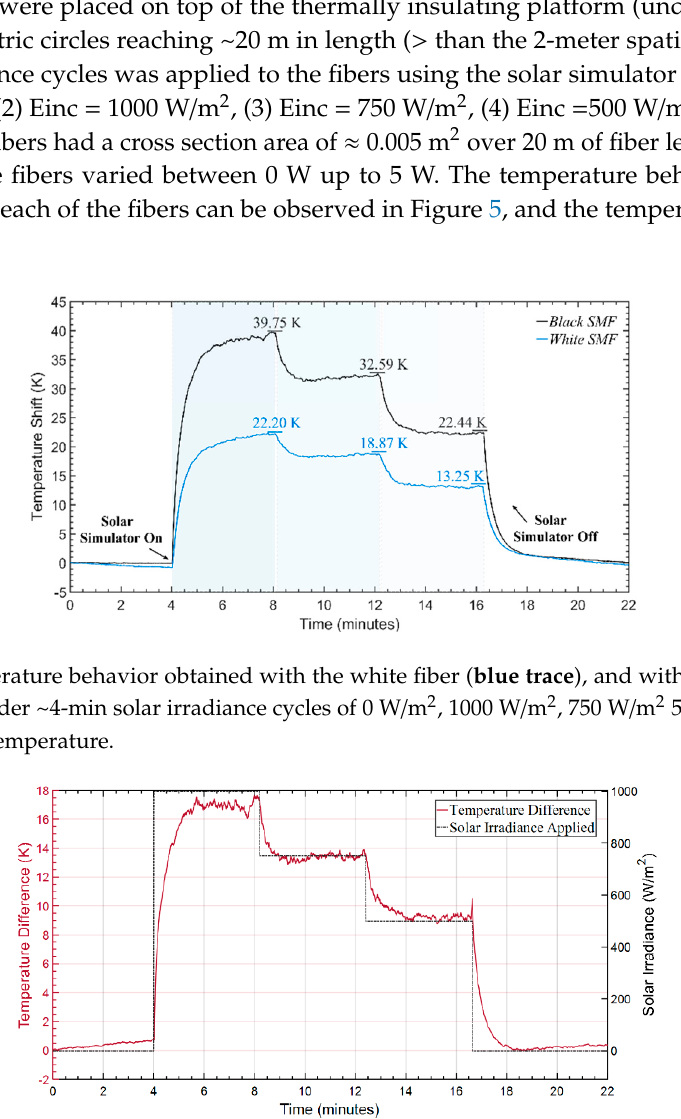
Figure 6. Temperature difference obtained between the black fiber and white fiber traces from Figure vs. the solar irradiance 5 vs. the solar irradiance applied.